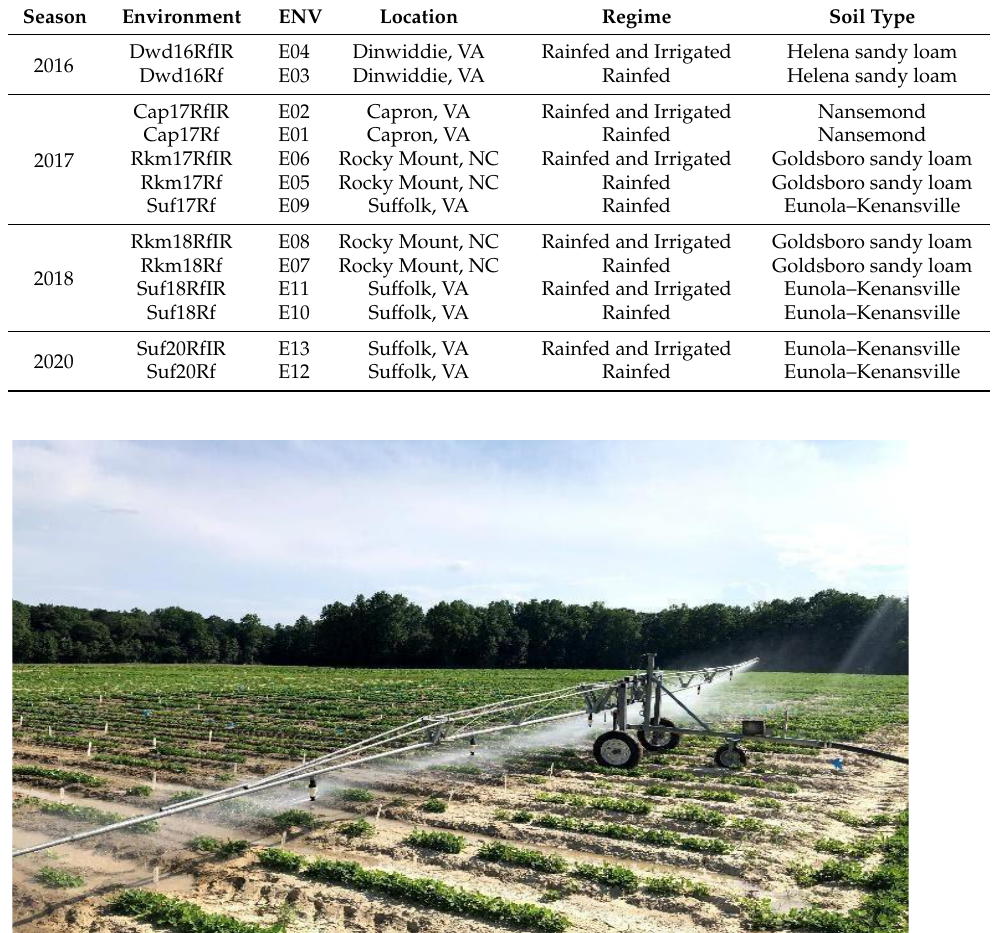
Table 2. Description of 13 peanut growing environments with location, water regime, and soil type in tests from 2016 to 2020.